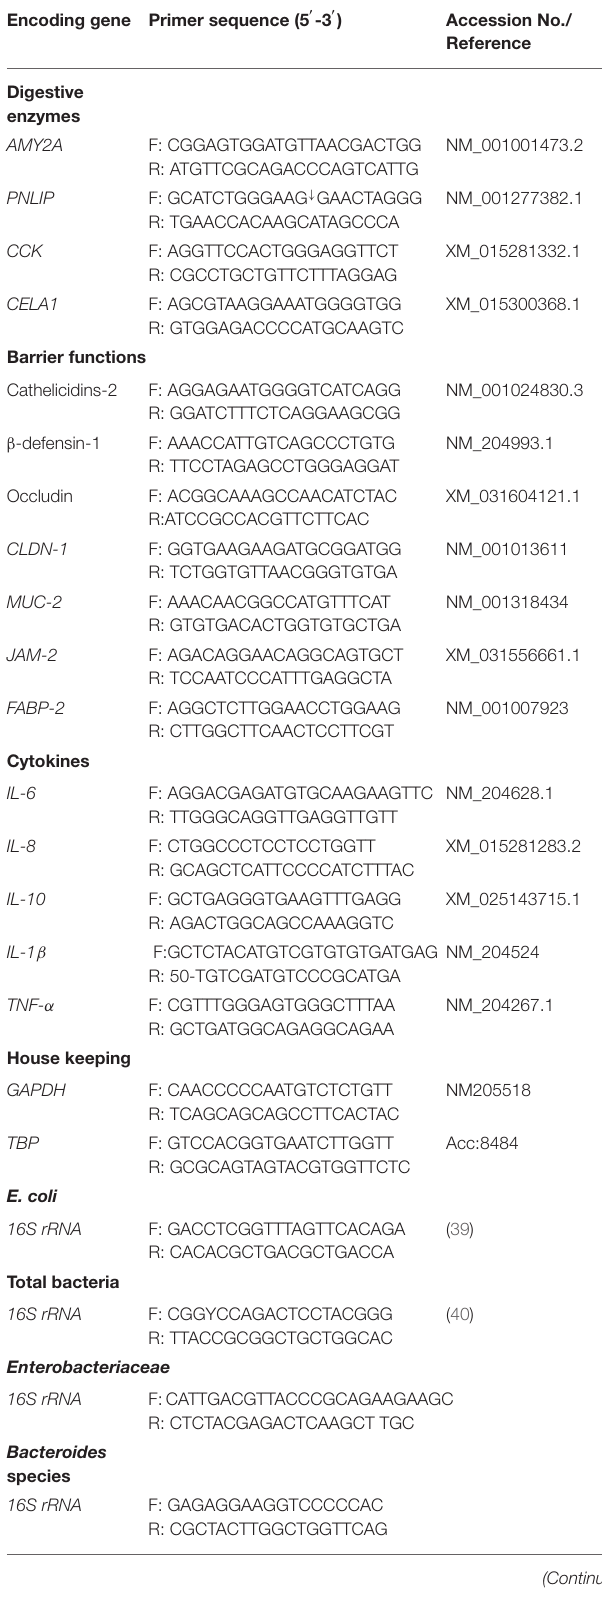
TABLE 2 | Primer sequences used for quantitative PCR assays. Encoding gene Primer sequence (5 ′ -3 ′